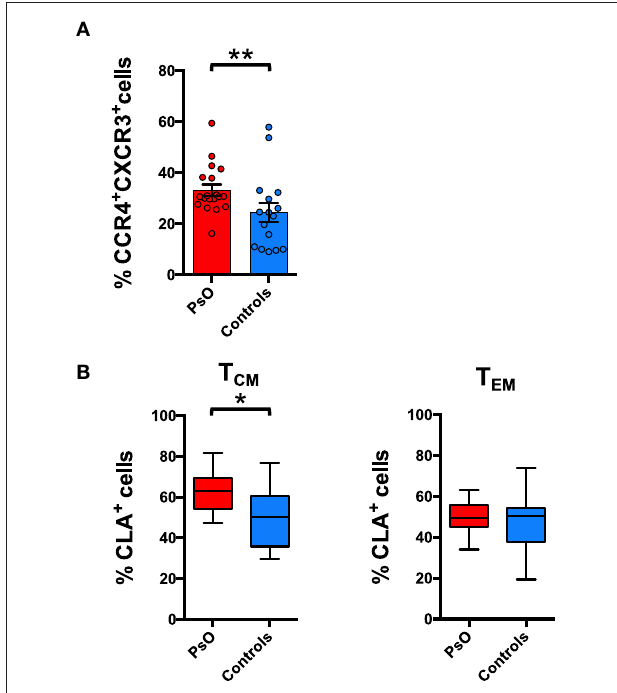
FIGURE 5 | Skin-tropic phenotype of circulating CD8 + T cells in psoriasis patients. (A) CD8 + cells from patients with cutaneous psoriasis (PsO) and healthy subjects were analyzed for the percentage of cells expressing chemokine receptors CCR4/CXCR3 in the CD45RA − CCR7 + (T CM ) compartment. Statistical analysis of the differences was performed by Mann–Whitney test. p -values < 0.05 were considered significant: ** p < 0.01. (B) CD8 + cells gated on the basis of the memory T CM or effector T EM phenotype, from patients with cutaneous psoriasis (PsO) and healthy subjects were analyzed for the percentage of CLA expressing cells in the CCR4 + CXCR3 − subpopulation. Statistical analysis of the differences was performed by Mann–Whitney test. p -values < 0.05 were considered significant: * p <